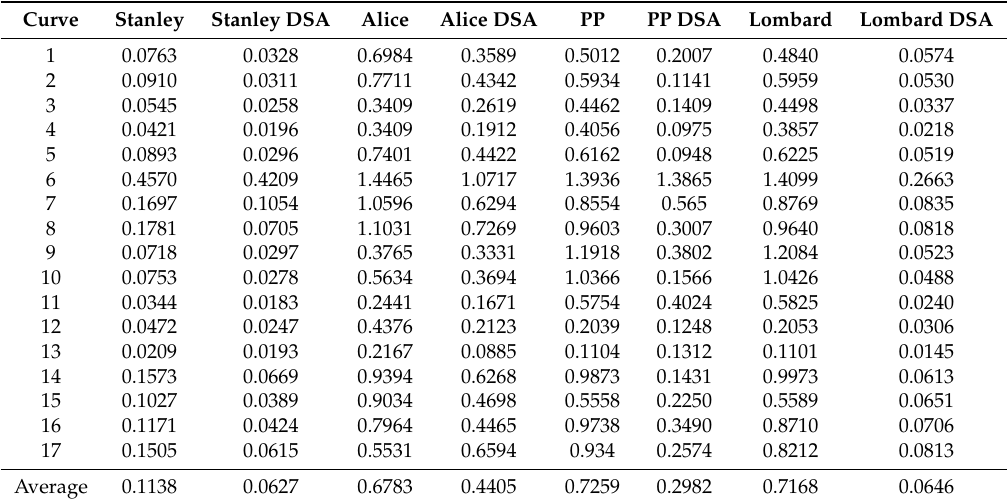
Table 4. Error comparison in sharp curves of different lateral control methods for the UTBM-3 dataset. Results are expressed in